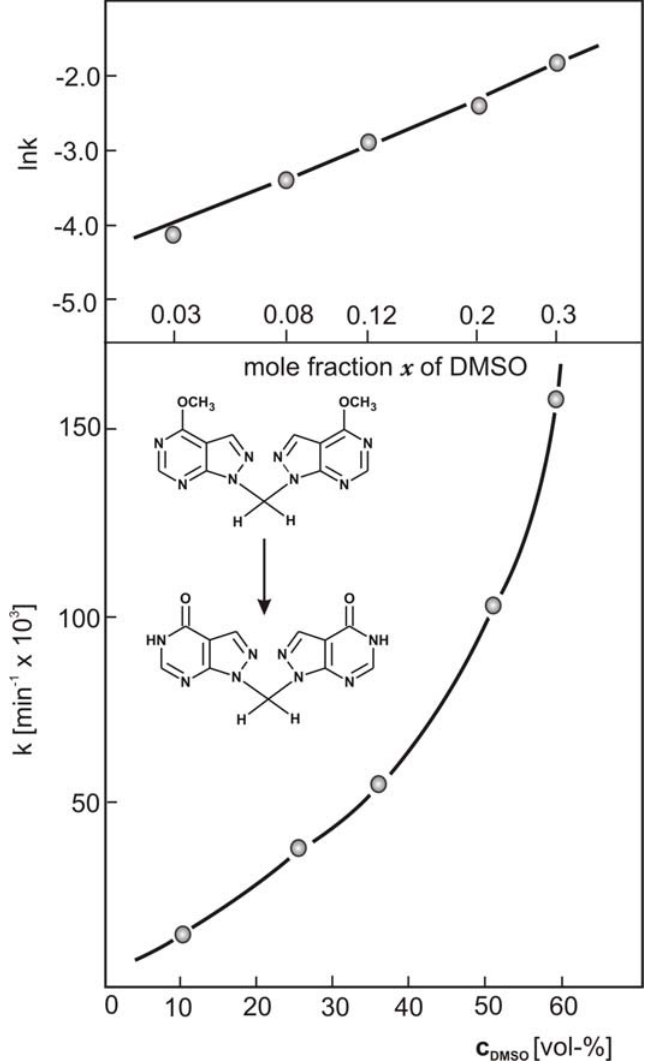
Figure 5 . Pseudo first-order rate constant k as well as ln k versus DMSO concentration for the reaction of 3a → 3b